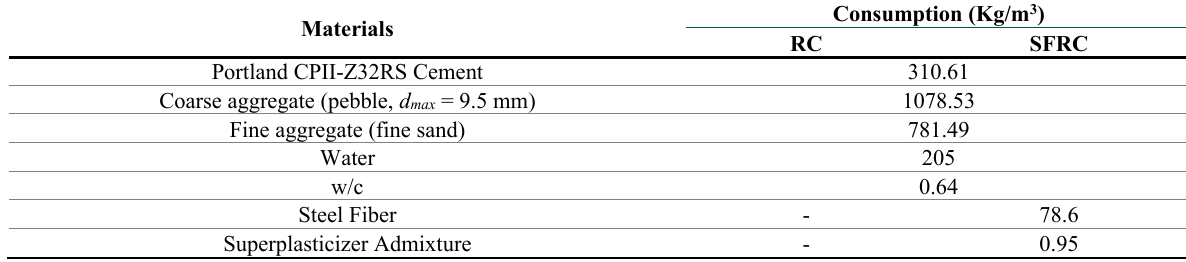
Table 1. Mixture Design.